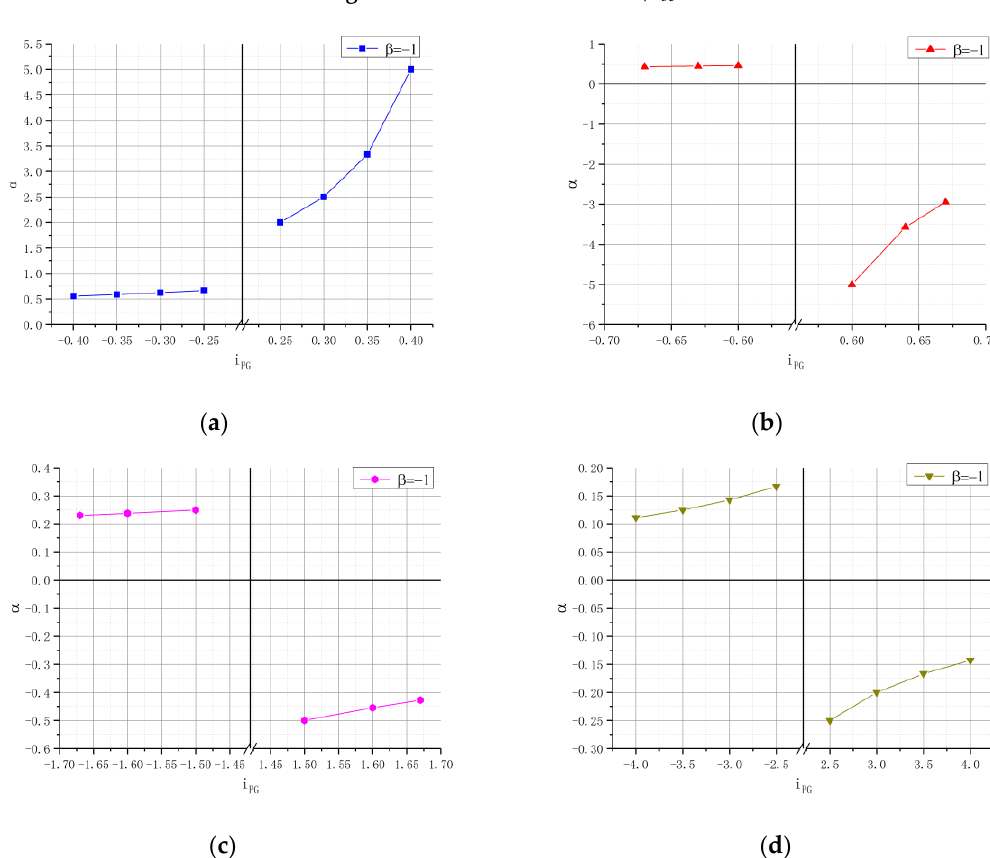
Figure 10. The range of transmission ratio, i oe , in four matching patterns. ( a ) The transmission range α of pattern a; ( b ) The transmission range α of pattern b; ( c ) The transmission range α of pattern c; ( d ) The transmission range α of pattern d.